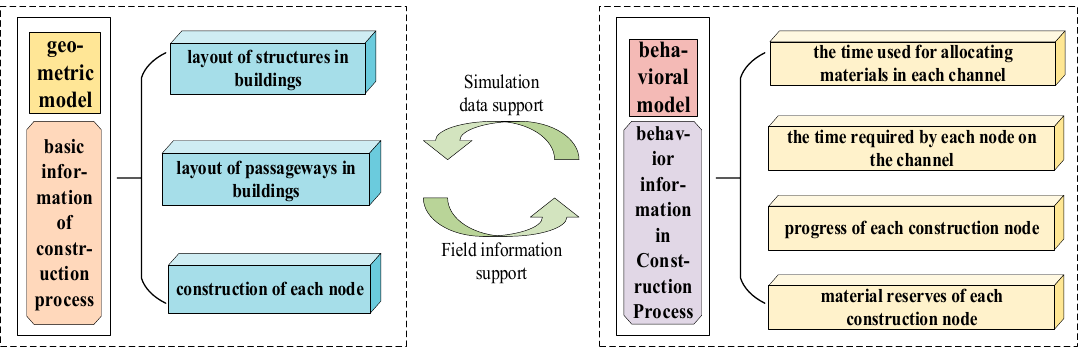
Figure 3. Information dynamic simulation in the virtual model.